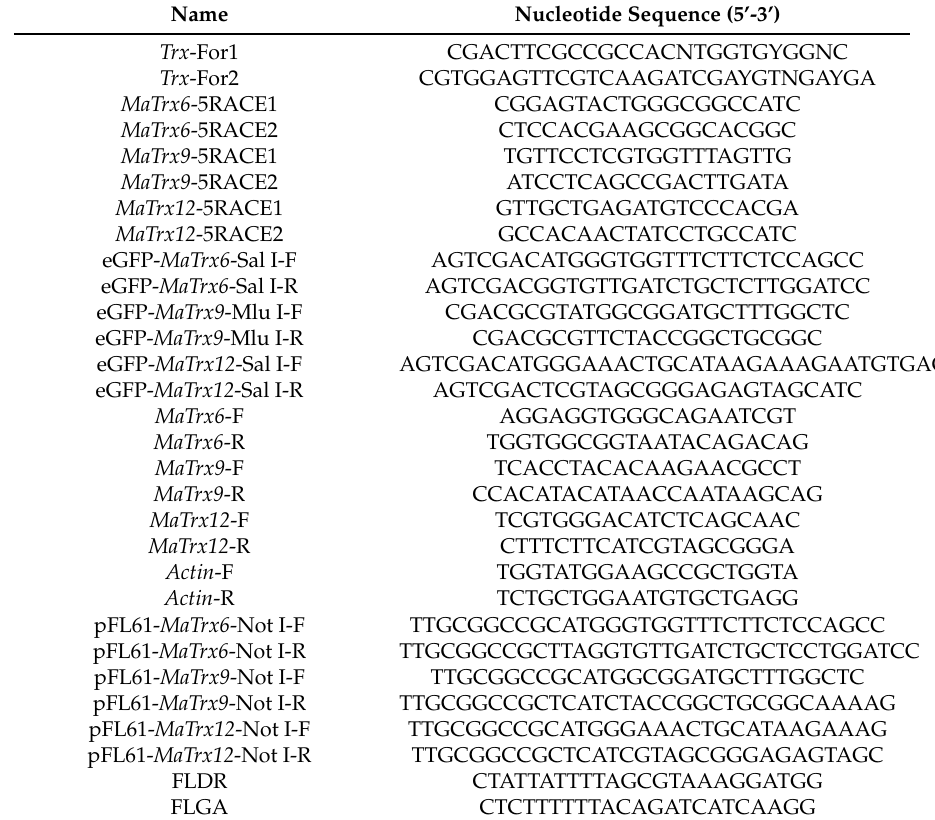
Table 1. Pimers used for the amplification of banana Trx genes full cDNA length, construction of eGFP and pFL61 vectors and